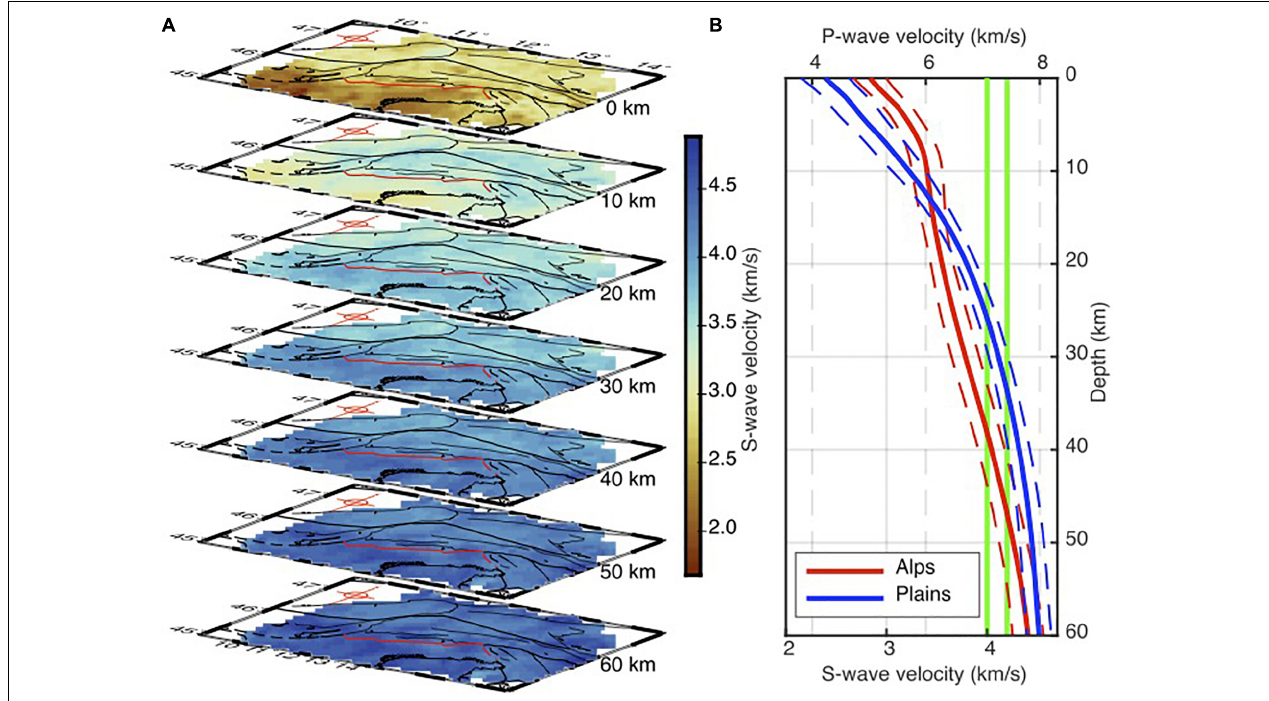
FIGURE 7 | (A) Depth slices showing variation of the S-wave velocity from the surface down to 60 km depth. The border between the Southeastern Alps and the Venetian and Friuli plains is shown by the red line. The thinner black lines depict the Neogene faults (Schmid et al., 2004, 2008; Handy et al., 2010). (B) The average 1D S-wave velocity profiles in the Southeastern Alps and the Venetian and Friuli plains. S-wave velocities of 4.0 and 4.2 km/s are shown by vertical green lines. The P-wave velocity profiles are calculated considering the average Poisson ratio of 0.256 for the continental crust (Christensen,